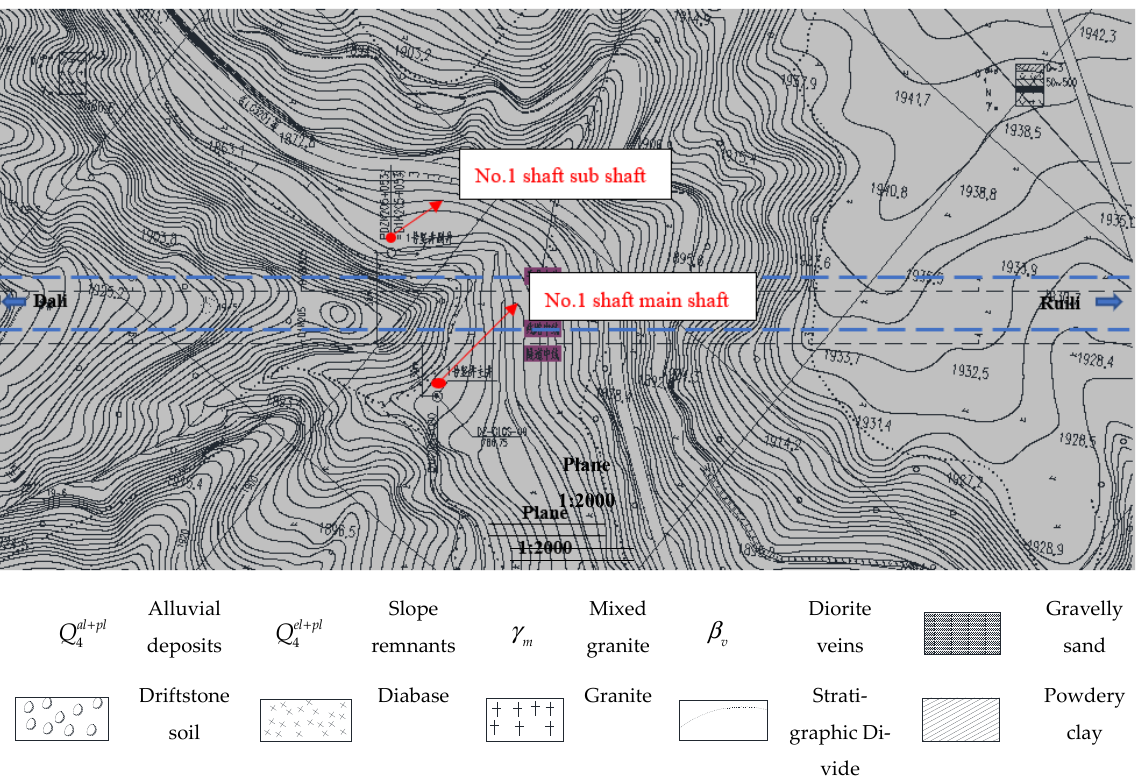
Figure 2. Topographic plan of shaft No. 1.